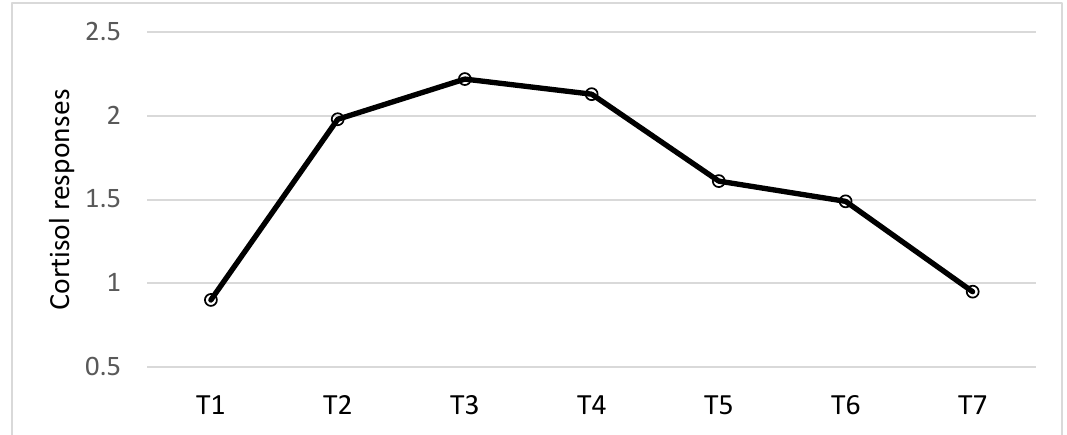
Figure 4. The diurnal cortisol responses (log transformed), including the cortisol awakening responses (CAR, T2, T3 and T4) and the stress responses (T5 and T6). Raw cortisol responses are reported in Table 2.